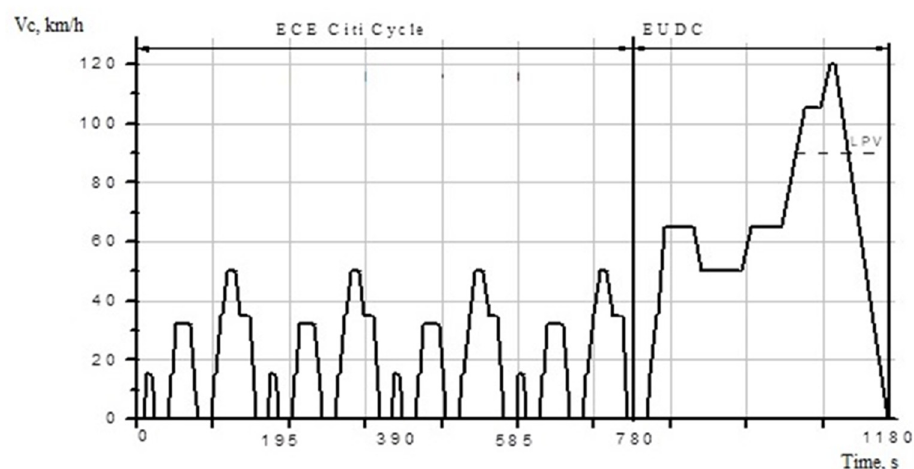
Figure 1. European modernized driving cycle.